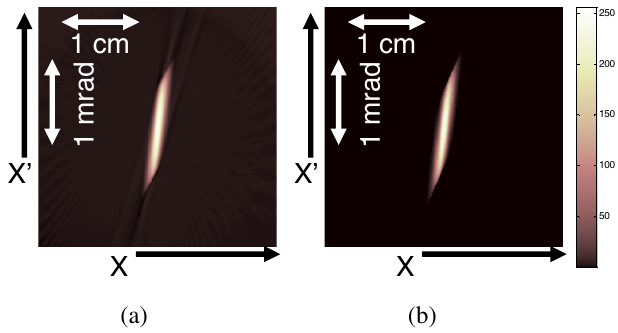
FIG. 3. (Color) X 0 X phase space for the 0.6 mA electron beam: (a) using tomography; (b) direct WARP .